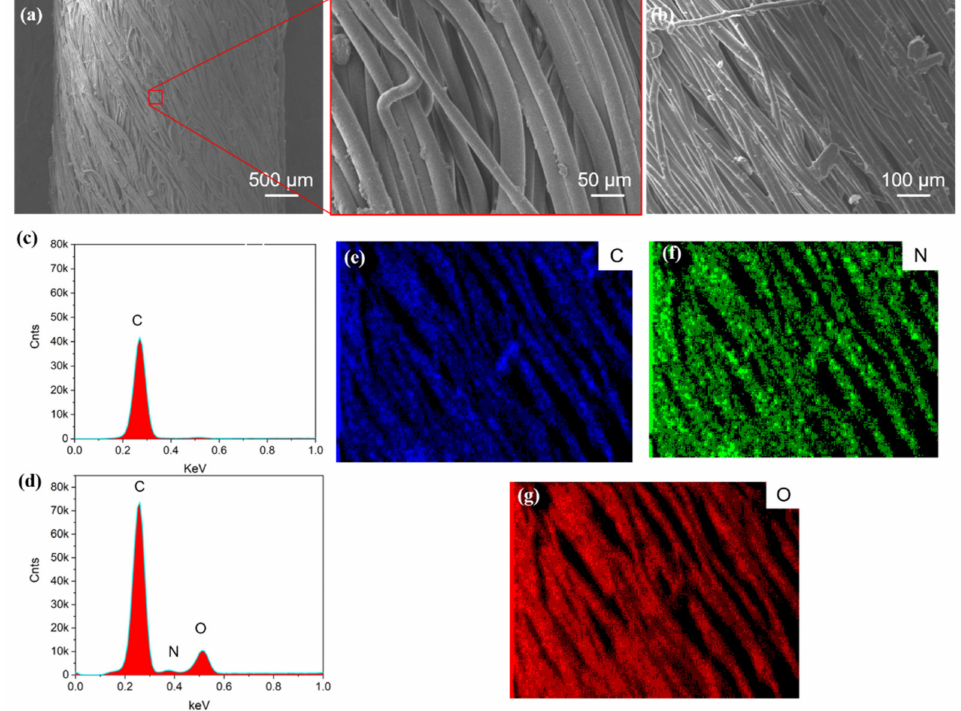
Figure 2. SEM images of ( a ) pure SEBS yarn and ( b ) PDA@SEBS yarn; EDX spectroscopy of ( c ) SEBS and ( d ) PDA@SEBS yarn; EDX mapping of SEBS@PDA yarn for ( e ) C, ( f ) N, and ( g )